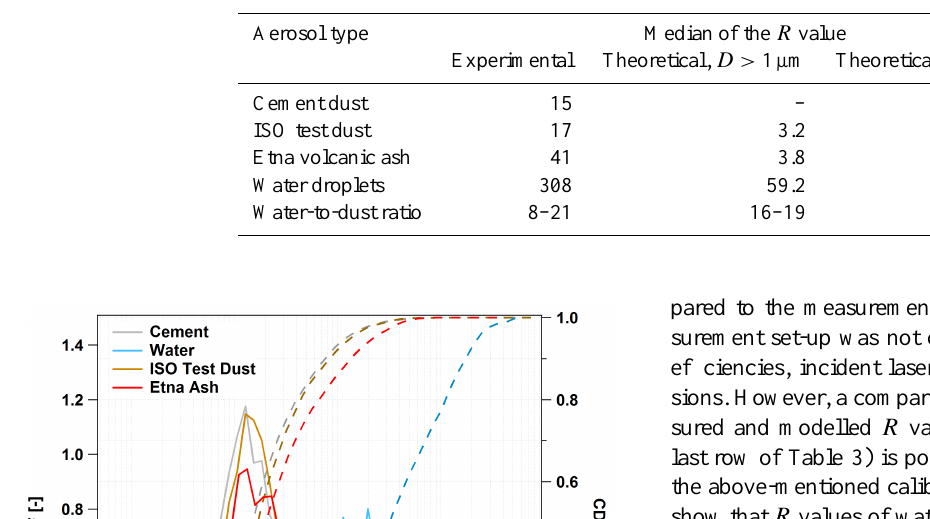
Table 3. Median experimental and theoretical R values for water and some dust types.